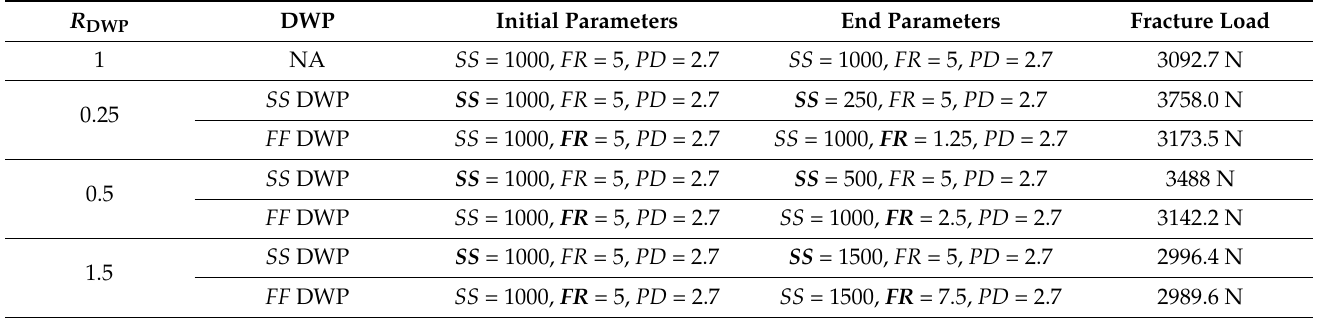
Table 4. Tensile Strength Results for dynamic welding parameter ( DWP